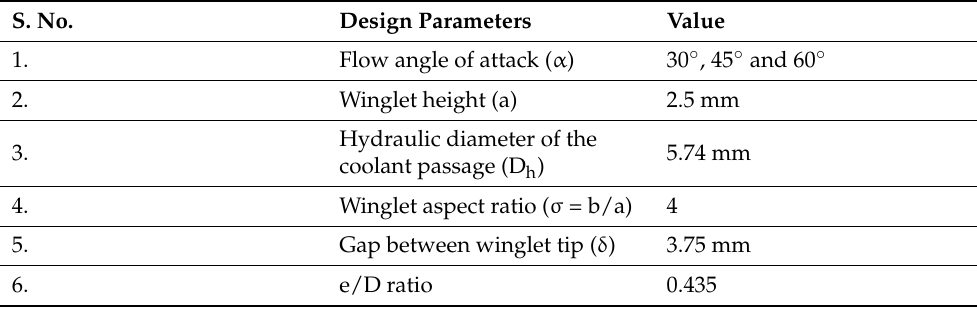
Table 2. Design parameters of the delta winglet vortex generator. S.